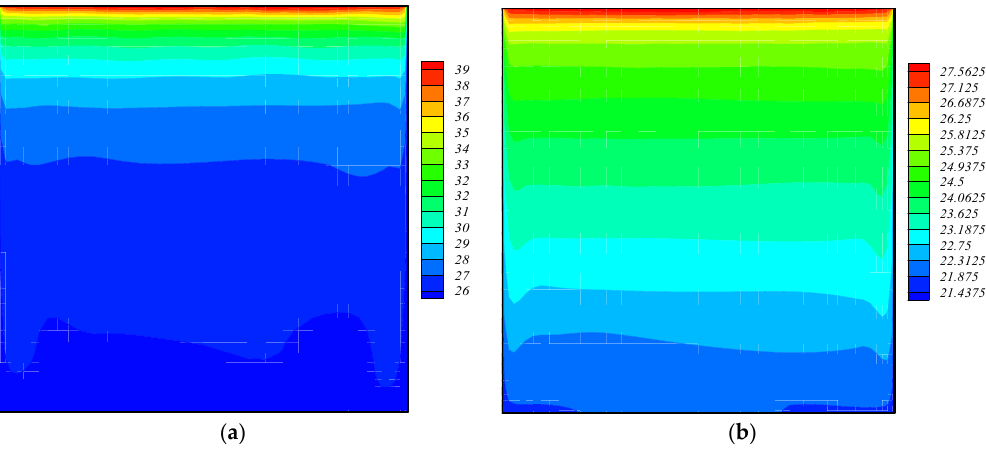
Figure 17. Temperature counters of the roof at 12 h for the room: ( a ) without and ( b ) with PCM.